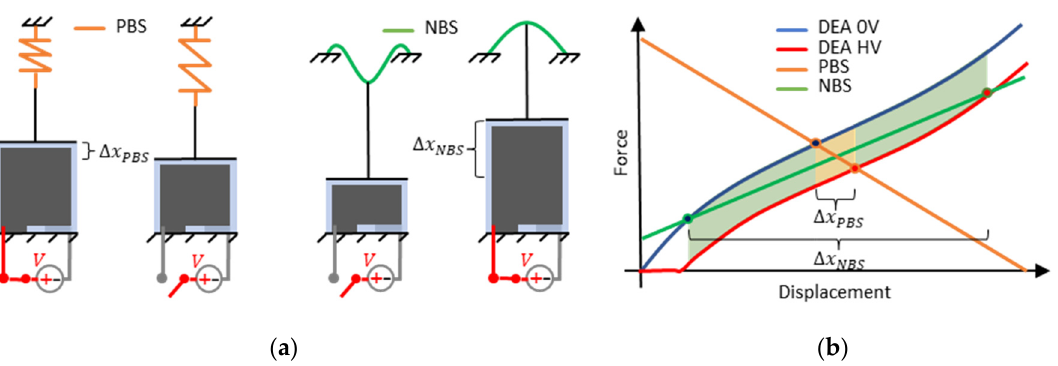
Figure 3. ( a ) Generic illustration of a SIP system coupled with a PBS in comparison with a system based on a similar SIP biased with an NBS, and ( b ) qualitative force-stroke curves for both systems.